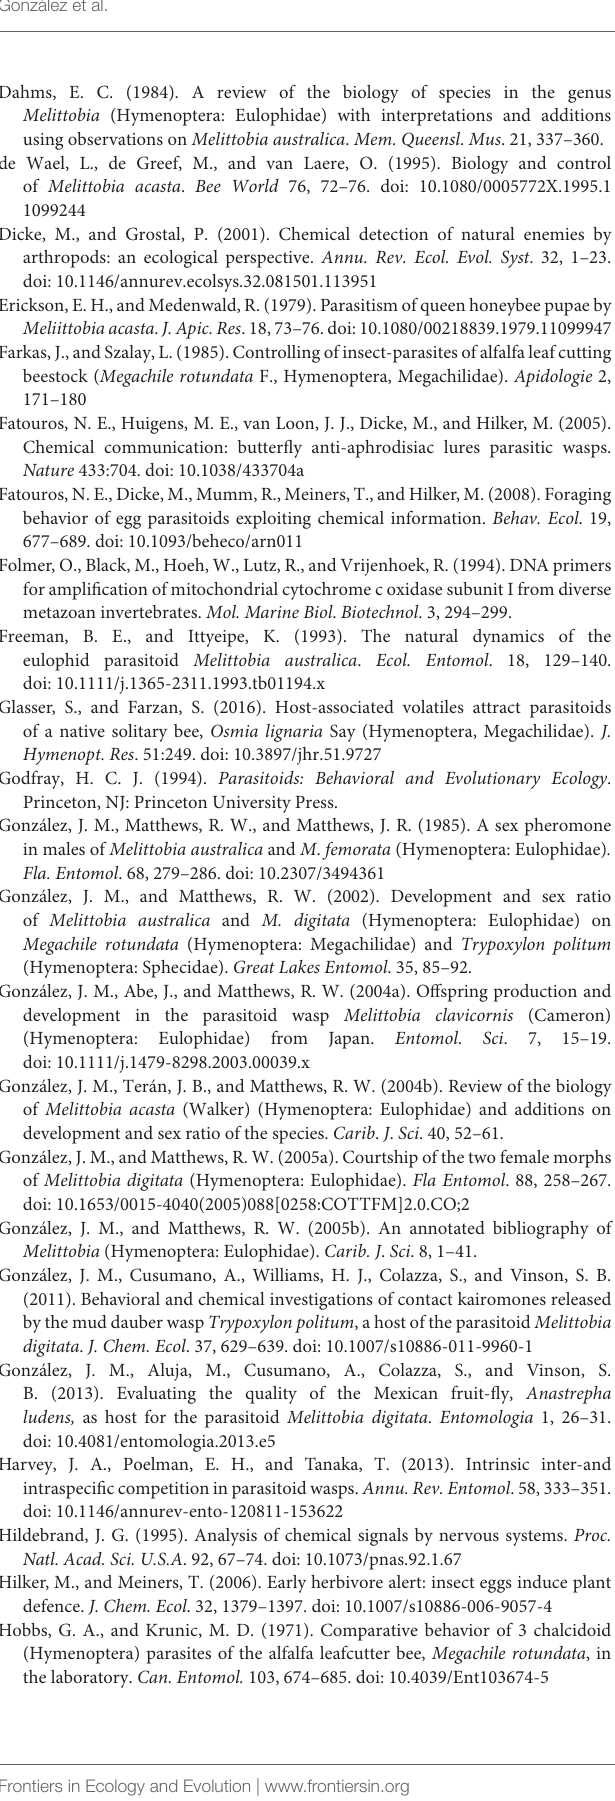
Frontiers in Ecology and Evolution |